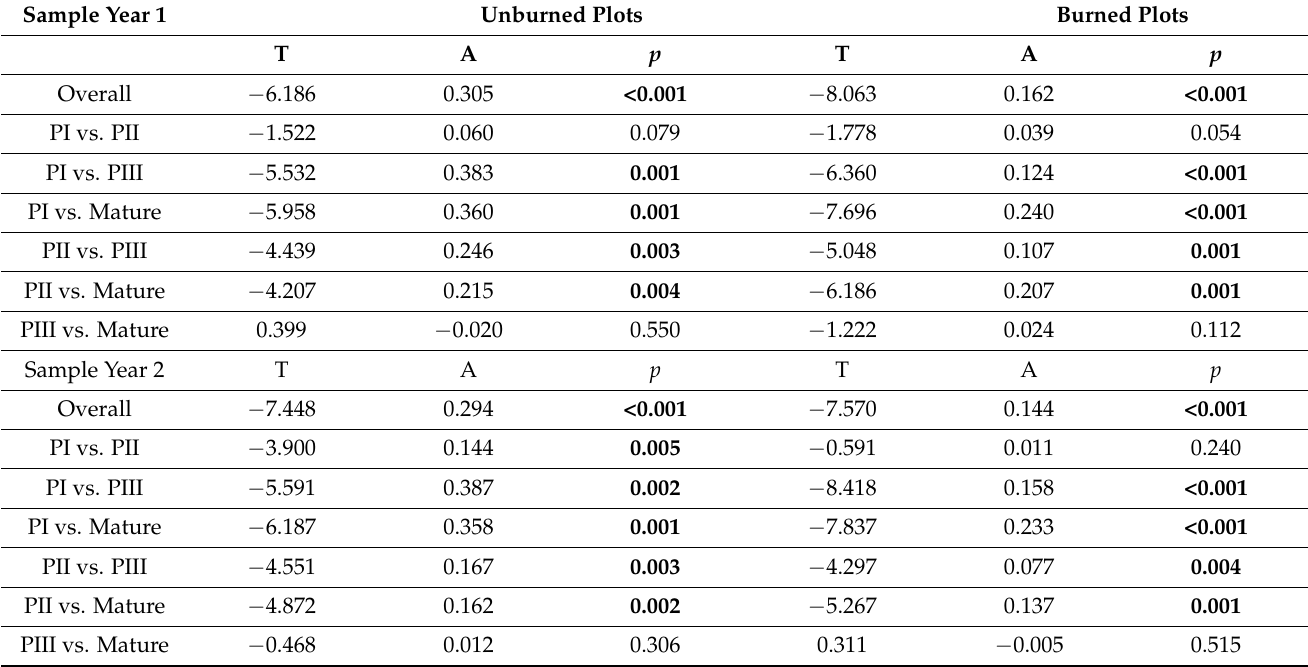
Table 2. Differences in plant community composition between woodland development phases (PI, PII, PIII and Mature) for unburned and burned plots for the two time periods sampled. MRPP outputs are reported: T = test statistic; A = chance-corrected within-group agreement; p = probability. Probability values < 0.05 are in bold font. See methods section for more details about the MRPP